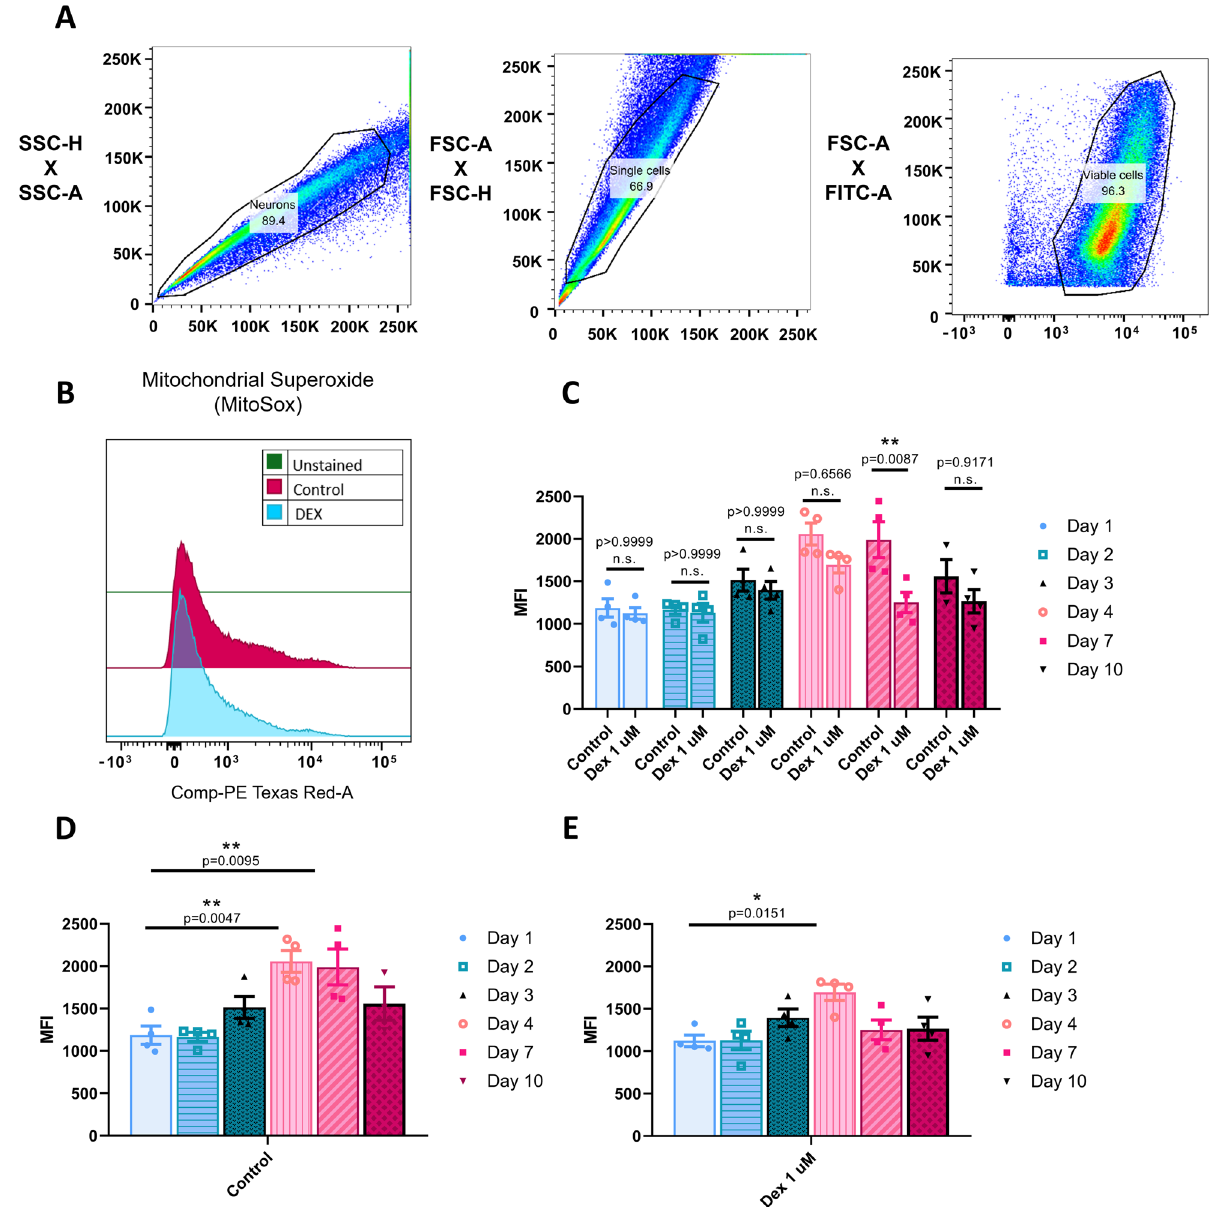
Figure 5. Dexmedetomidine reduced ROS production at day 7. ( A ) Gating strategy to select living neurons, stained with Calcein AM. ( B ) Representative MFI of mitochondrial superoxide production by neurons exposed to DEX compared to controls. ( C ) Quantification of MFI of mitochondrial ROS production by control and DEX-exposed cells at days 1, 2, 3, 4, 7 and 10. Control: D1 = 992 ± 108.7, D2 = 1007 ± 53.44, D3 = 1319 ± 129.4, D4 = 1828 ± 129.1, D7 = 1613 ± 212.0, D10 = 1245 ± 197.5 and DEX: D1 = 1034 ± 68.06, D2 = 823 ± 108.2, D3 = 1153 ± 103.3, D4 = 1401 ± 98.57, D7 = 1021 ± 117.2, D10 = 949 ± 136.6. Values are mean ± SEM F (5, 35) = 2.226, **p = 0.0087 by two-way ANOVA with Tukey’s post hoc analysis for multiple comparisons. ( D ) Quantification of MFI of mitochondrial ROS production on control cells at days 1, 2, 3, 4, 7 and 10. Control: D1 = 992 ± 108.7, D2 = 1007 ± 53.44, D3 = 1319 ± 129.4, D4 = 1828 ± 129.1, D7 = 1613 ± 212.0, D10 = 1245 ± 197.5 Values are mean ± SEM F (5, 17) = 7.313, P = 0.0008 by one-way ANOVA with Tukey’s post hoc analysis for multiple comparisons. ( E ) Quantification of MFI of mitochondrial ROS production on DEX-exposed cells at days 1, 2, 3, 4, 7 and 10. DEX: D1 = 1034 ± 68.06, D2 = 823 ± 108.2, D3 = 1153 ± 103.3, D4 = 1401 ± 98.57, D7 = 1021 ± 117.2, D10 = 949 ± 136.6. Values are mean ± SEM F (5, 18) = 3.968, P = 0.0133. n = 3–4 brains per